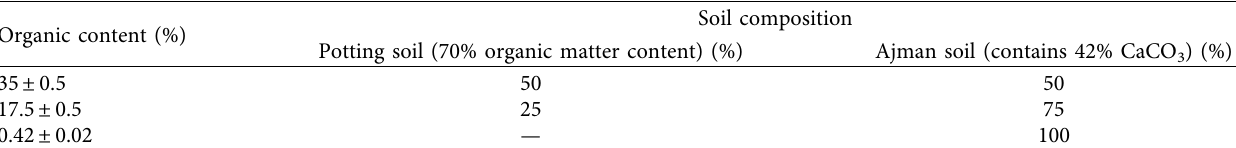
Table 1: Soil composition with different organic contents.